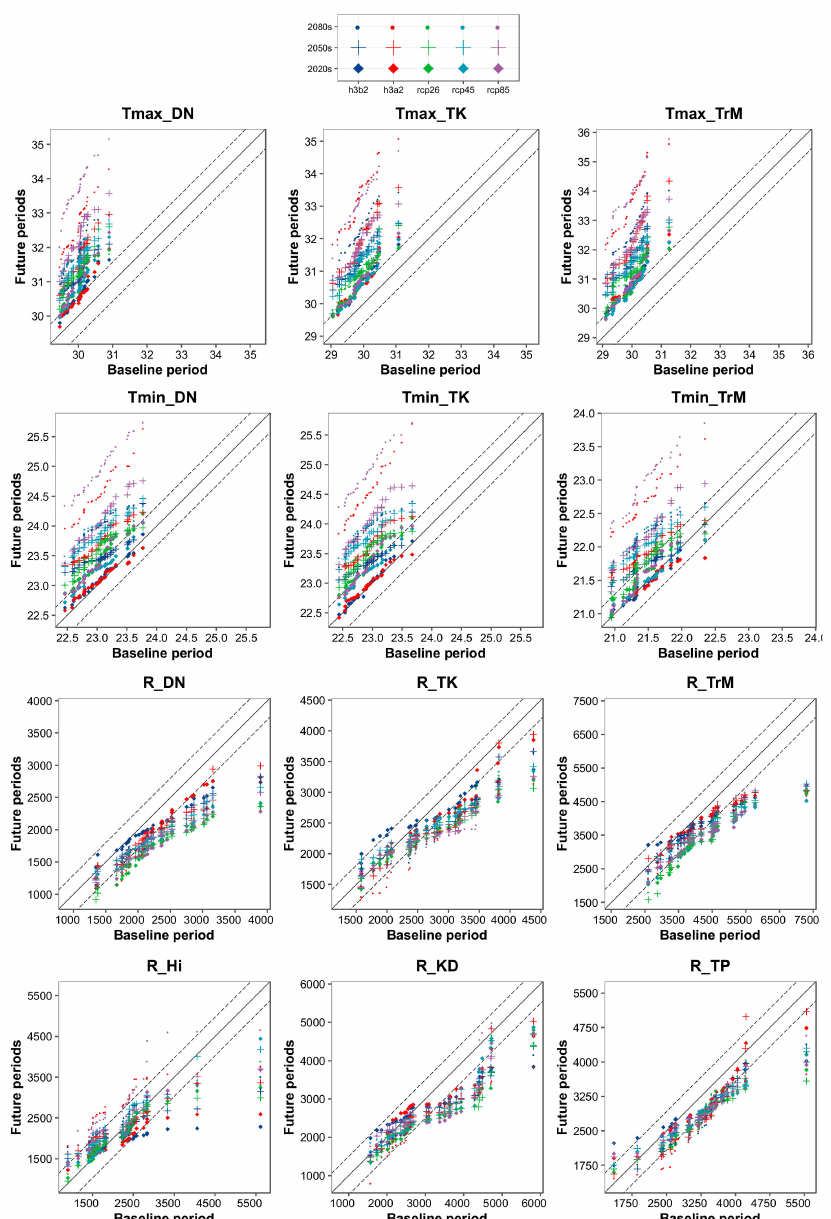
Figure 8. Innovative-¸Sen trend plots for comparing the near-, middle-, and far-future periods to the reference period under multiple scenarios. Tmax, Tmin, and R stand for maximum and minimum temperature and